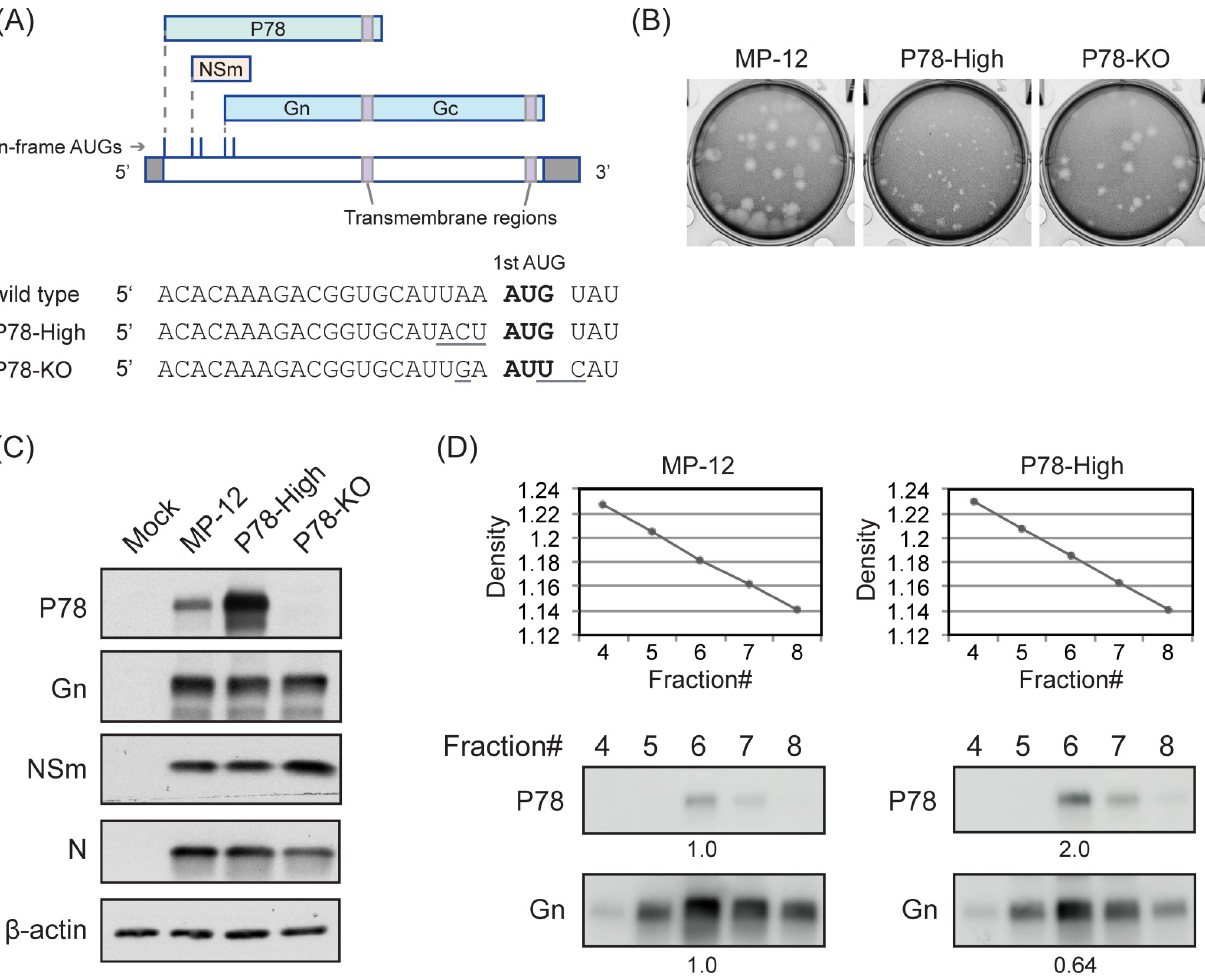
Fig 1. Characterization of P78-High virus. (A) Coding strategies of RVFV M segment and nucleotide sequence of mutated sites. RVFV M segment RNA is depicted in anti-genomic sense orientation. Underline indicates mutated sites. (B) Plaque morphologies of mutant viruses in Vero E6 cells. (C) Viral protein expression profiles. Vero E6 cells were infected with indicated viruses at MOI of 3 and harvested at 8 h p.i. Intracellular protein accumulation was analyzed by Western blot. (D) Western blot analysis of purified virus particles. Vero E6 cells were infected with the indicated viruses at MOI of 1. Culture supernatant was harvested at 16 h p.i. and subjected to sucrose gradient ultracentrifugation. Fractions were collected and sucrose densities were measured (top panels). Each fraction was subjected to Western blot for detection of P78 and Gn proteins using anti-NSm [15] and anti-Gn monoclonal (4D4) antibodies, respectively. MP-12 and P78-High samples were loaded on the same gel. Numbers indicate band intensities of P78 and Gn in P78-High samples relative to that in MP-12